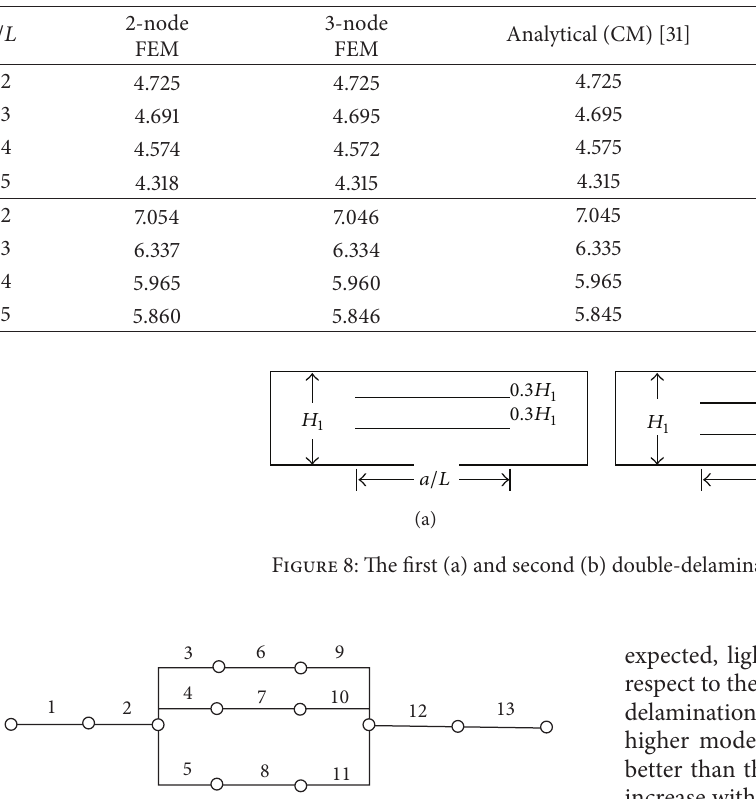
Table 3: The first and second nondimensional frequency parameter ( 𝜆 ) for model 1.